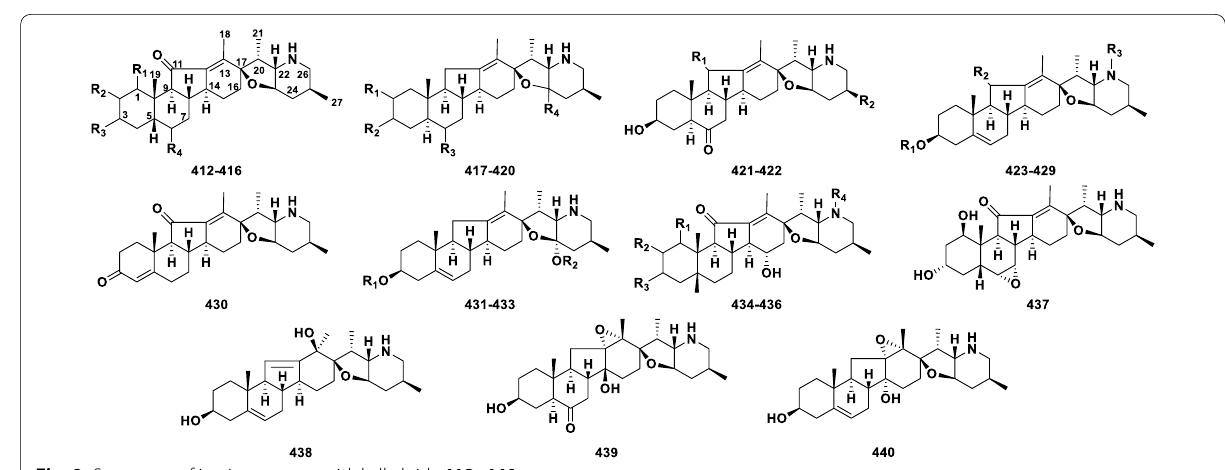
Fig. 9 Structures of jervine type steroidal alkaloids